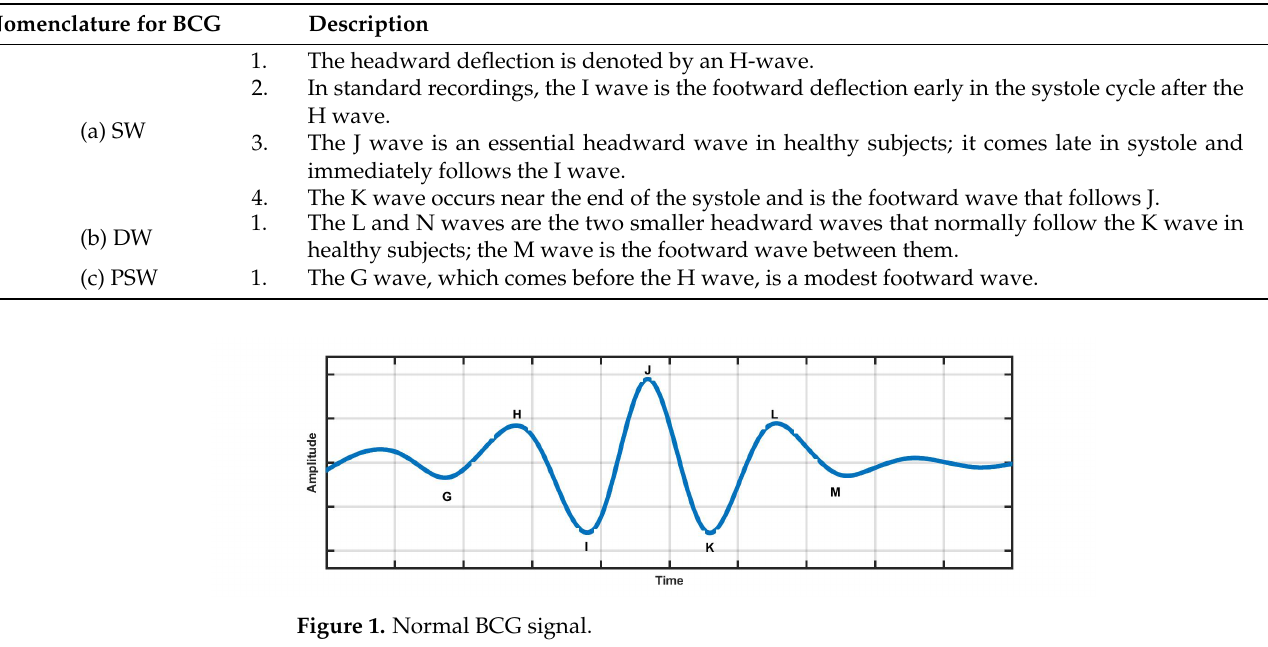
Table 1. The nomenclature of BCG signal waves in terms of systolic waves (SW), diastolic waves (DW), and pre-systolic waves (PSW) [20].